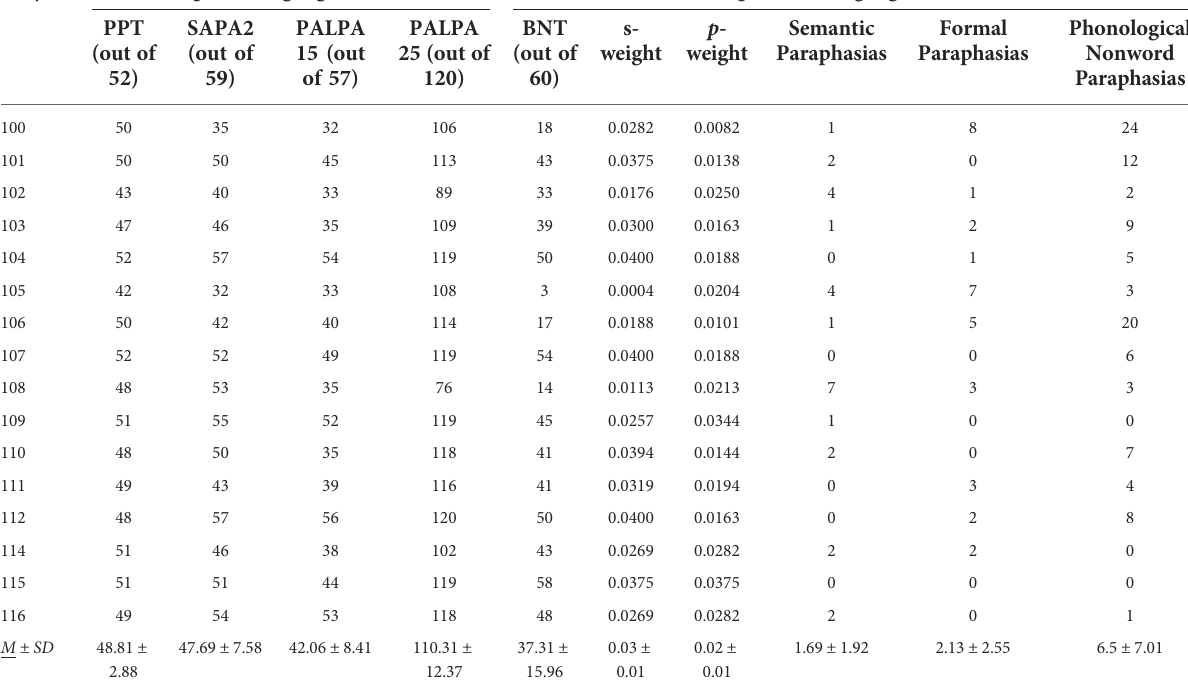
TABLE 2 Raw scores on receptive and expressive language